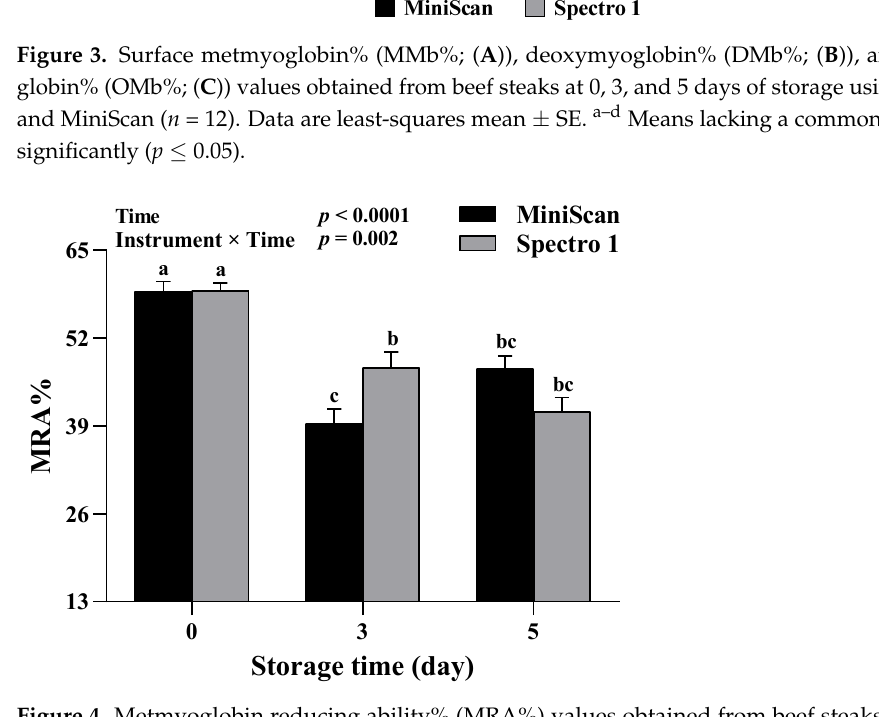
Figure 4. Metmyoglobin reducing ability% (MRA%) values obtained from beef steaks at 0, 3, and 5 days of storage using Spectro 1 and MiniScan ( n = 12). Data are least-squares mean ± SE. a–c Means lacking a common letter differ significantly ( p ≤ 0.05).